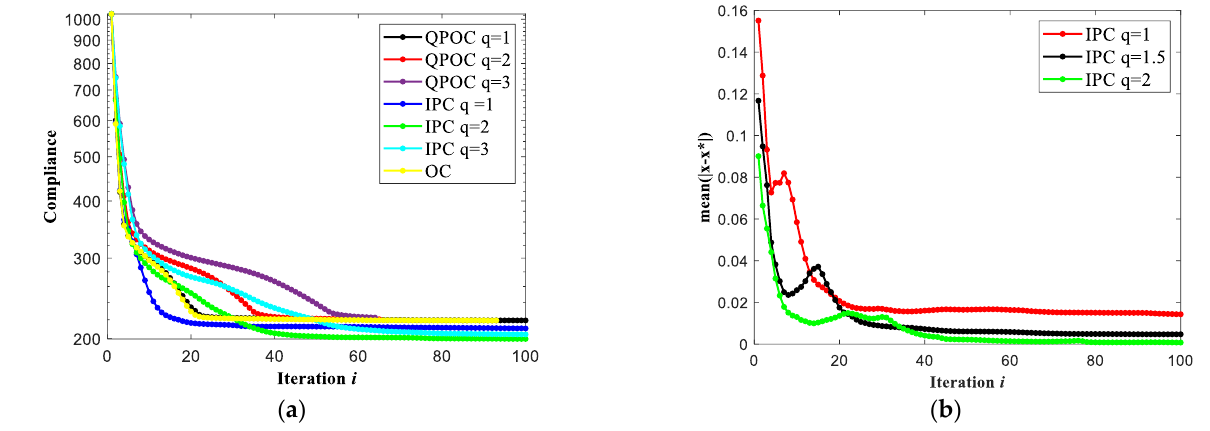
Figure 4. Convergence curves for the MBB beam using different methods and parameters: ( a ) the changes in the compliance; ( b ) average iteration step size using different curvature parameters.